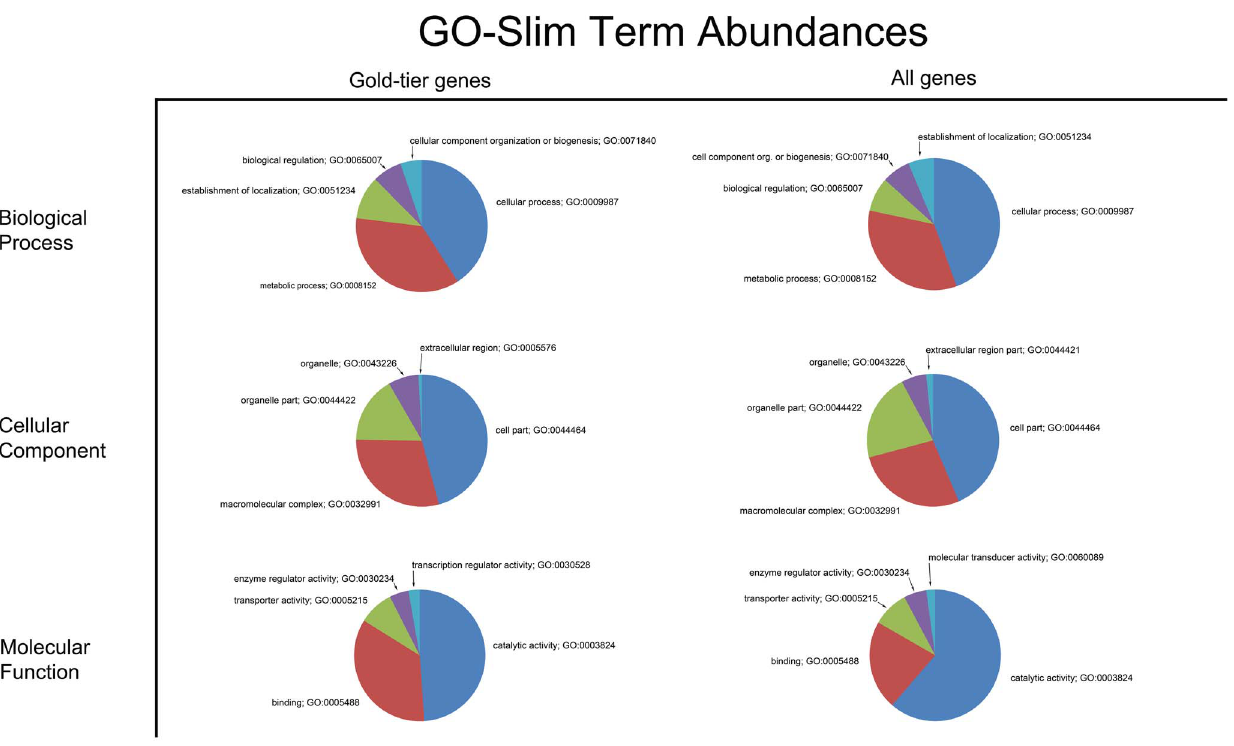
Figure 2. GO-Slim term abundances. Shown are pie charts presenting the relative abundance of the five most frequently encountered GO-Slim terms for both the 838 gold-tier PUT subset, as well as the complete 49,613 PUT set. GO-Slim terms provide a less granular representation of the gene annotation information conveyed by terms from the full GO ontology, thereby offering a higher-level perspective on the functional capacity contained in the Lymantria dispar gene set relative to fully-qualified terms. GO-Slim terms are stratified with respect to the ontology’s three primary domains: biological process, cellular component and molecular function.